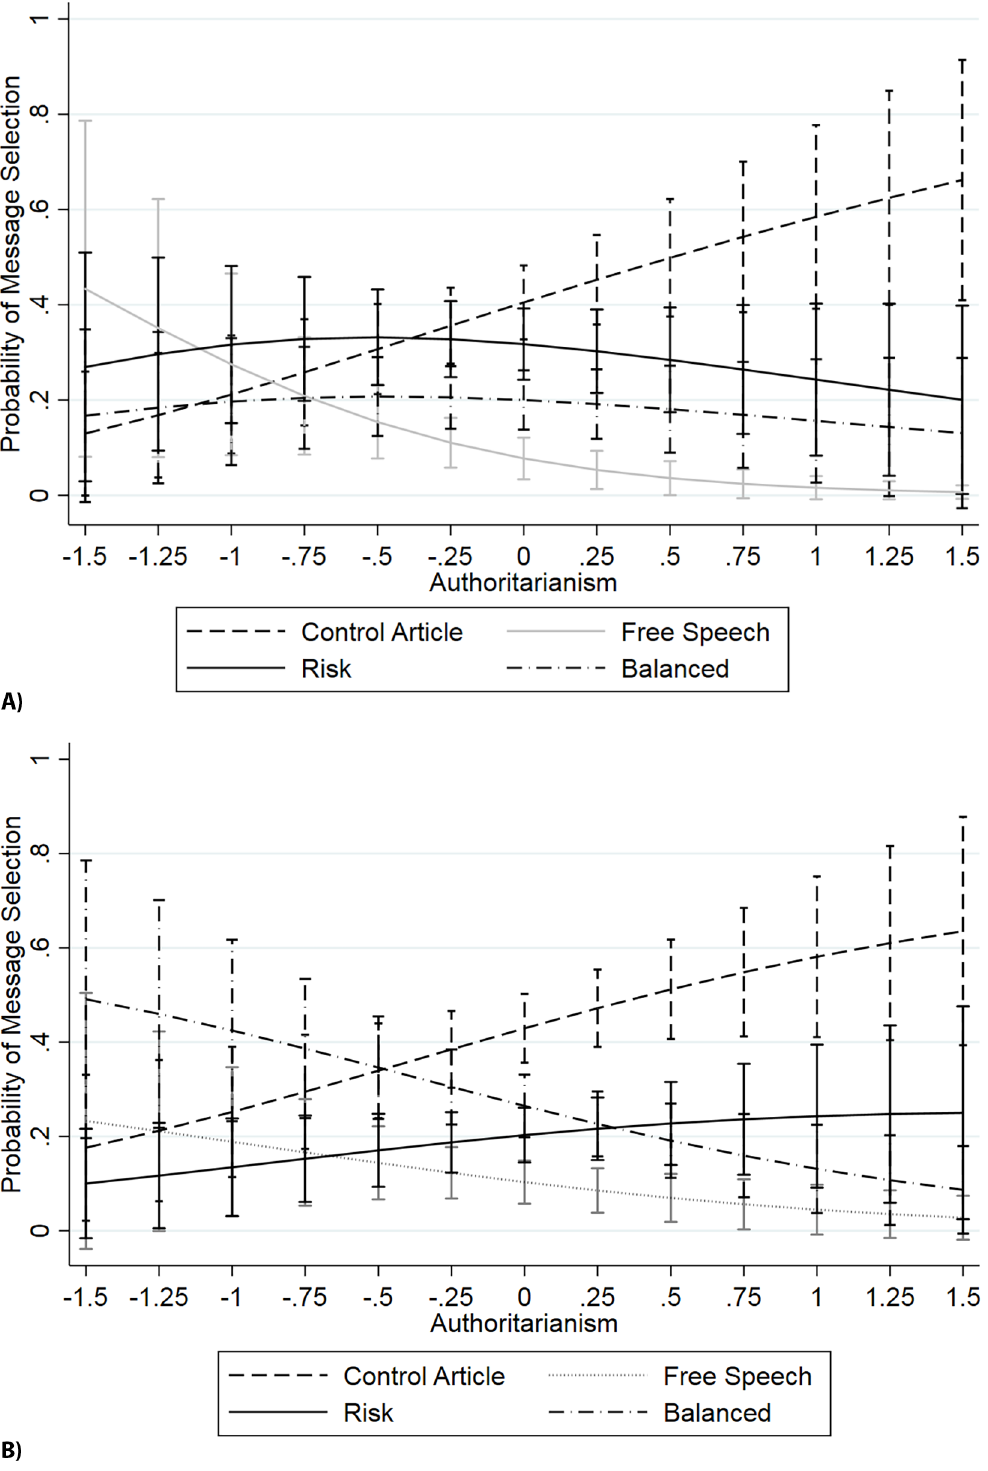
Figure 1. Probability of message selection by authoritarianism and country. Note. Probabilities computed for high knowledge participants. Top panel (A) is USA, bottom panel (B) is Canada.